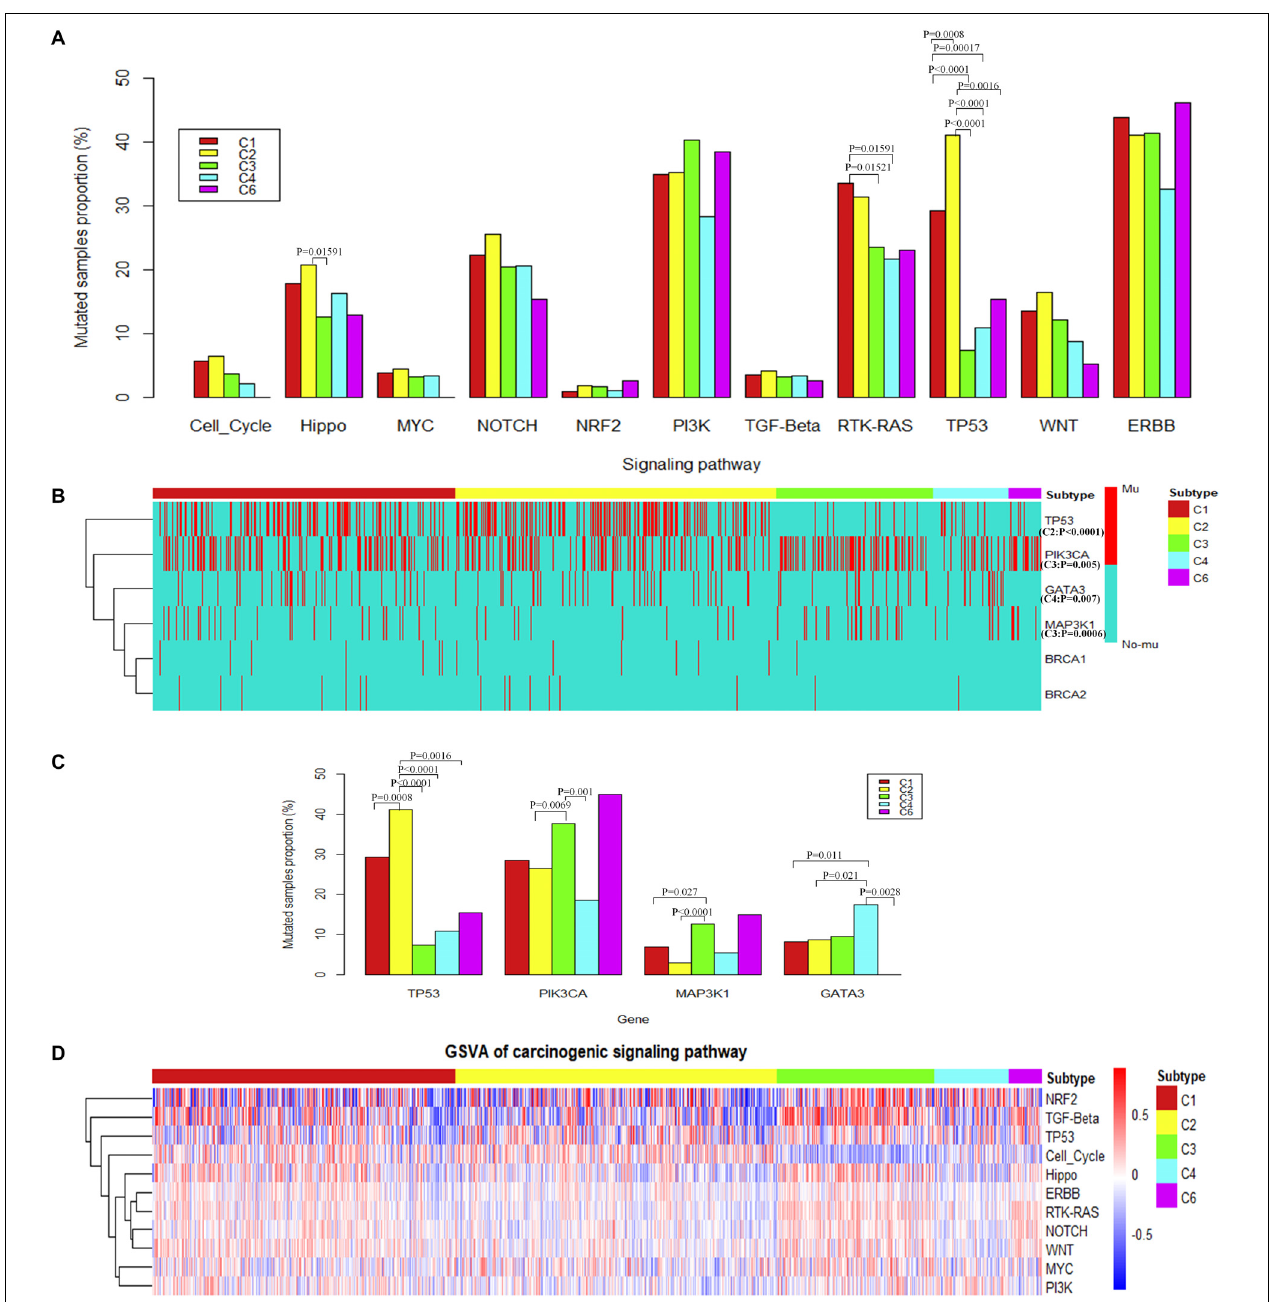
FIGURE 3 | The alteration of carcinogenic signaling pathways in genetic mutations and transcriptional process. (A) Proportion of mutated samples for canonical signaling pathways in different immune subtypes (Fisher’s exact test, “Mutated samples proportion” is measured as the ratio of the number of samples with mutation in the pathway among the total number of samples in each immune subtype). (B) Genes with significant difference of mutations among different immune subtypes (Fisher’s exact test) or potential target genes for different immune subtypes. (C) The histogram shows the proportion of mutated samples for potential target genes in breast invasive carcinoma immune subtypes. (D) The heatmap shows enrichment scores of breast invasive carcinoma immune subtypes in canonical signaling pathways.